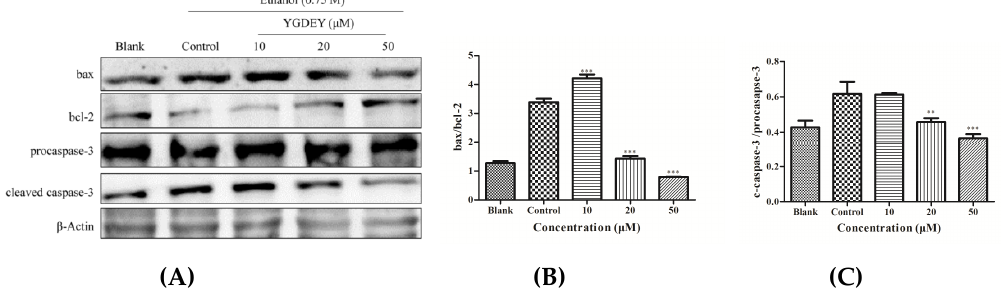
Figure 4. ( A ) The expressions of bax, bcl-2, procaspase-3, and caspase-3 p20 in HepG2 cells. Cells were pretreated with YGDEY (10, 20, and 50 µ M) for 24 h before induction by 0.75 M ethanol for 2 h. β -Actin was used as an internal control. ( B ) and ( C ) The ratios of bax/bcl-2 and cleaved-caspase-3/procaspase-3 were calculated. Data are shown as means ± SD ( n = 3). ** compared with the control group, p < 0.01. *** compared with the control group, p < 0.001.